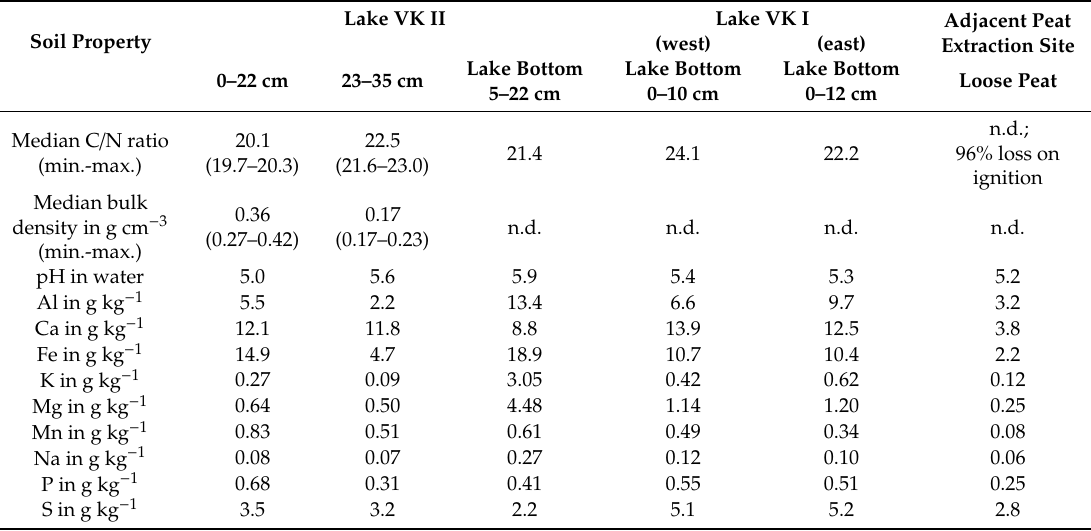
Table 1. Soil properties in di ff erent horizons at the study transects (see Figure 1); elements in aqua regia digestion; n.d. = not